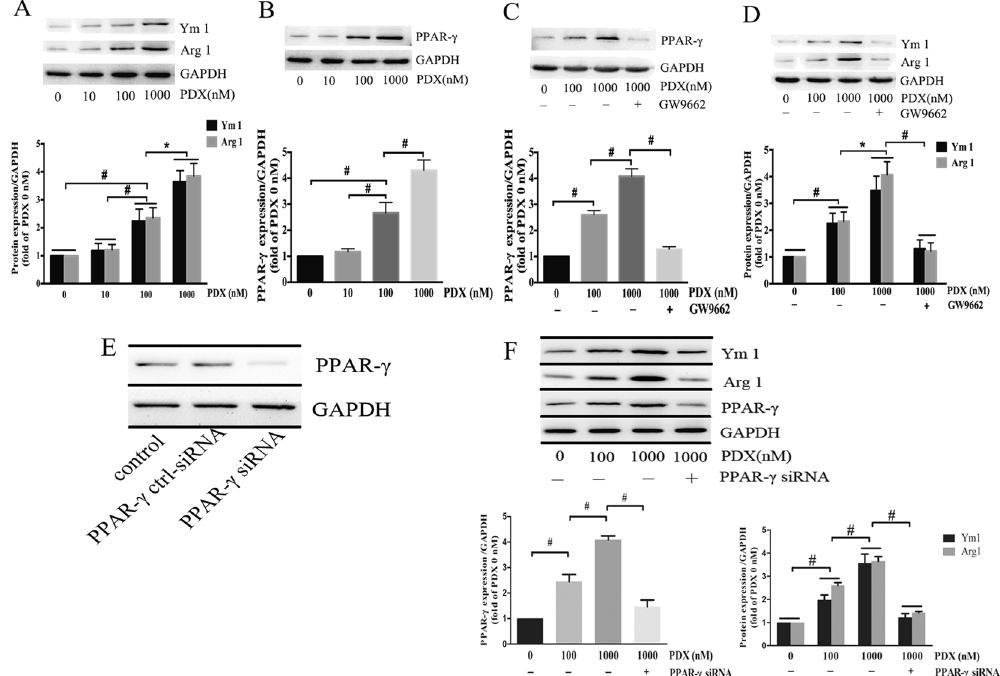
Figure 7. PDX up-regulated the expression of M2 markers in RAW264.7 cells. RAW264.7 cells were stimulated by vehicle (0.03% ethanol) or different concentrations of PDX (10 nM, 100 nM or 1000 nM) for 24 h in the absence or presence of GW9662 (1 µ M). The expression of Arg1, Ym1 and PPAR- γ was analyzed by Western blot ( A , B ). And the effect of PDX (1000 nM) treatment was blocked by a PPAR- γ antagonist GW9662 ( C , D ). The effect of siRNA against PPAR- γ on the expression of PPAR- γ , Ym1 and Arg1 was also assessed by Western blot ( E , F ). Quantification for protein expression was normalized by GAPDH. Data represented the mean ± SEM from three independent experiments. * P < 0.05, # P < 0.01.